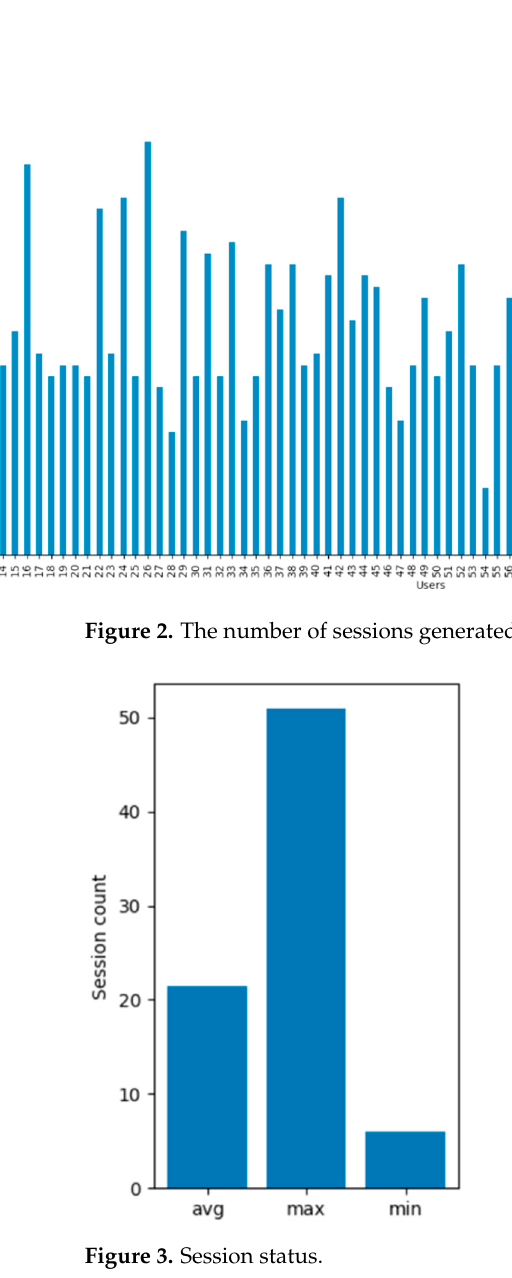
Figure 3. Session status. Figure 3. Session